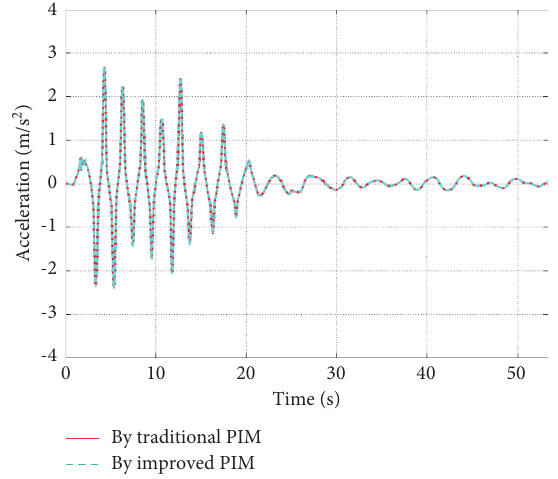
Figure 5: Acceleration time-history curve of pier top under rare earthquake excitation.